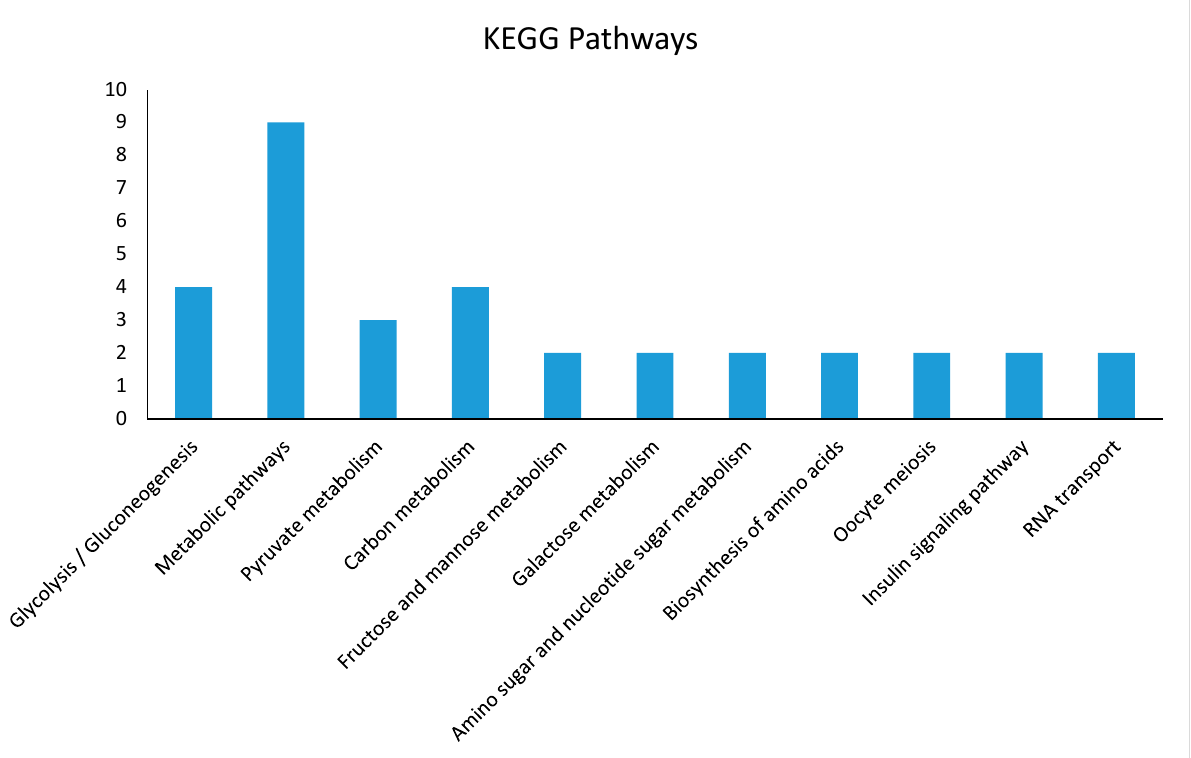
Figure 6. Distribution of KEGG pathway enrichment analysis ( p < 0.05) of DEPs of small and developing primary follicles. DEPs are mainly associated with glycolysis, gluconeogenesis, carbon metabolism, pyruvate metabolism, galactose metabolism, fructose and mannose metabolism, oocyte meiosis, endocytosis, and lysosome activities. The X -axis represents DEPs in different pathways, and Y -axis represents the number of proteins involved in each KEGG pathway enrichment. KEGG: Kyoto Encyclopedia of Genes and Genomes